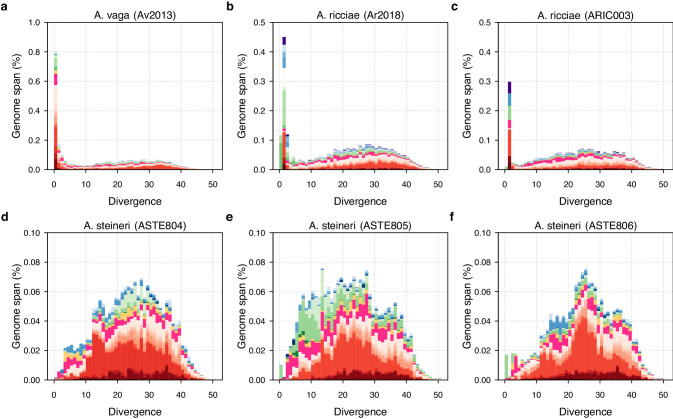
TE divergence landscapes for individual Adineta genomes.